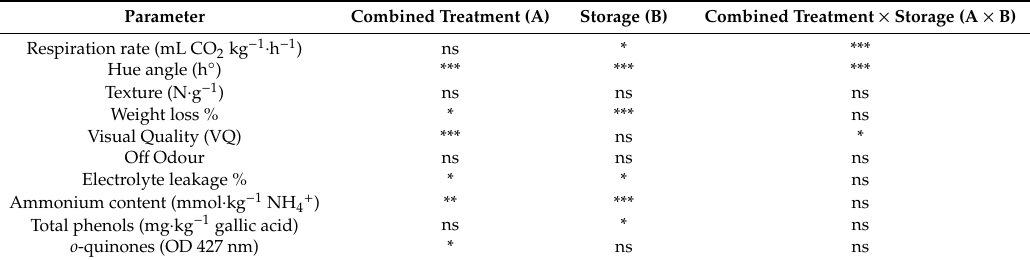
Figure 4. Changes in visual quality ( A ), hue angle ( B ), and respiration rate ( C ) in fresh-cut iceberg lettuce dipped in oxalic acid (OA), citric acid (CIT) or control (CTRL) and stored in modified atmosphere packaging (MAP). Data are mean value ( n = 3) ± standard deviation. Table 1. E ff ect of combined treatments (dipping in oxalic acid, citric acid or water and packaging in MAP) (A), storage (3, 6, 8 days at 8 ◦ C) (B), and their interaction (A × B) on quality parameters of fresh-cut iceberg